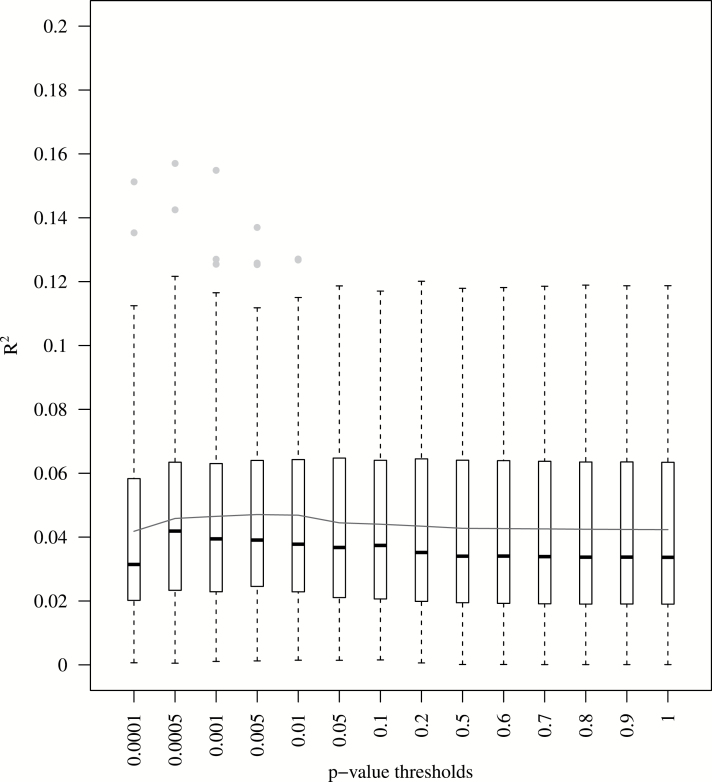
Polygenic score and lifespan. Each box represents the interquartile range (IQR) with the median as a black horizontal line; the whiskers represent values 1.5*IQR; outliers are represented as separate points. The continuous black horizontal line connects the means within each p value threshold.